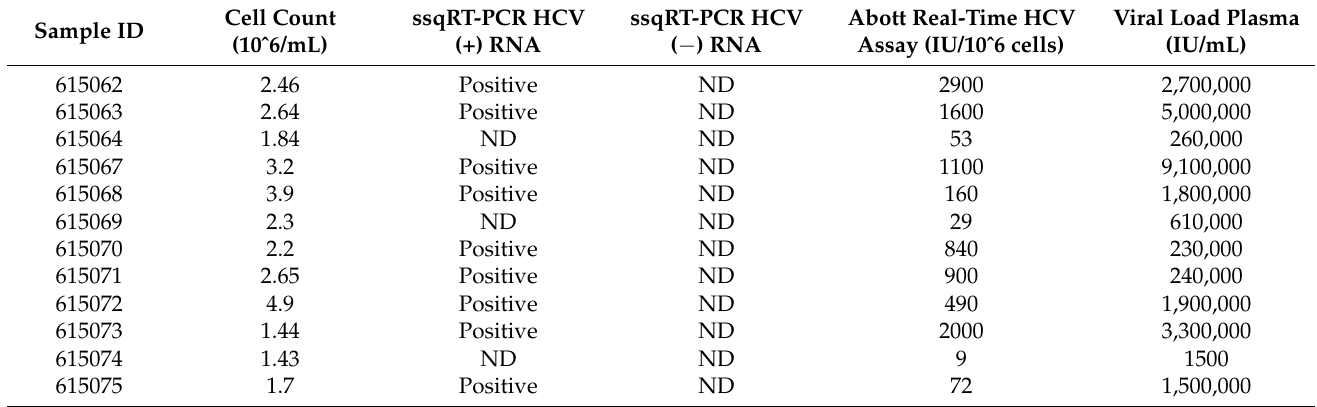
Table 1. Detection of total and strand specific (+ and − ) HCV RNA in PBMCs from HCV +